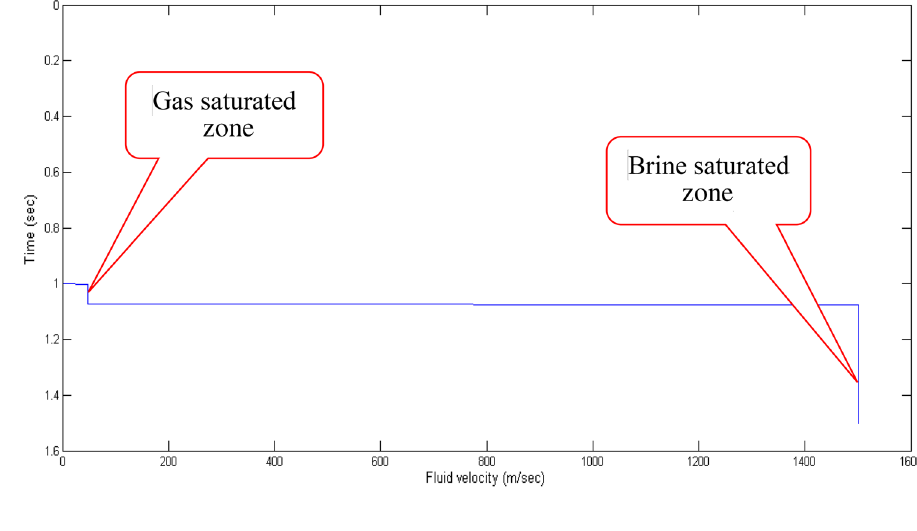
Fig. 7 Fluid velocity plot of case 1